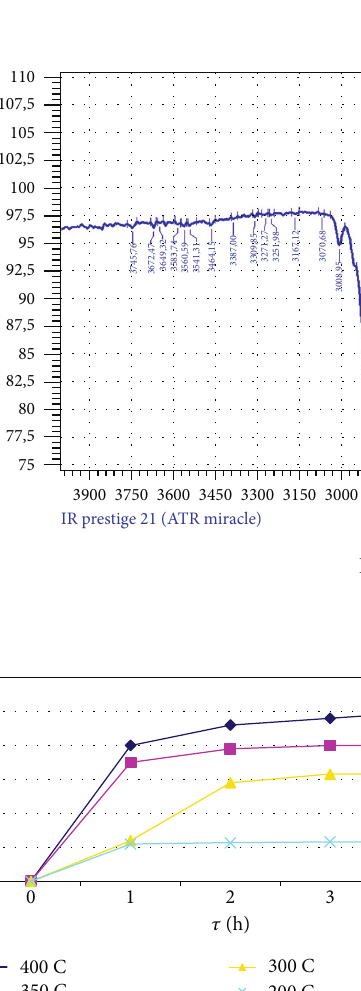
Figure 2: The bleaching clay spectrogram.